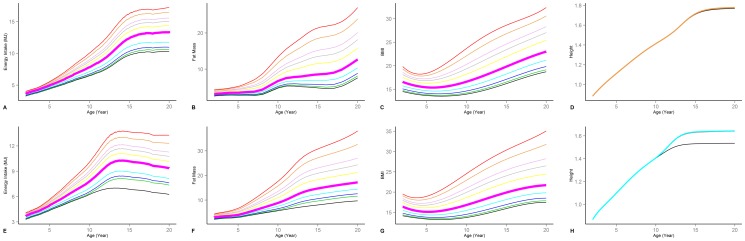
Growth trajectory for simulated subjects.Tracking 3rd, 5th, 10th, 25th, 50th, 75th, 85th, 90th, 95th, and 97th CDC BMI percentiles. Median curves are bold and pink. Male and Female results for (A & E) Energy intake; (B & F) BMI; (C & G) Fat percentage; (D & H) Height (only 3rd, 5th, 10th, and 50th percentiles are shown).